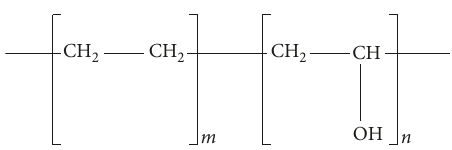
Figure 1: Structure of ethylene vinyl alcohol copolymer